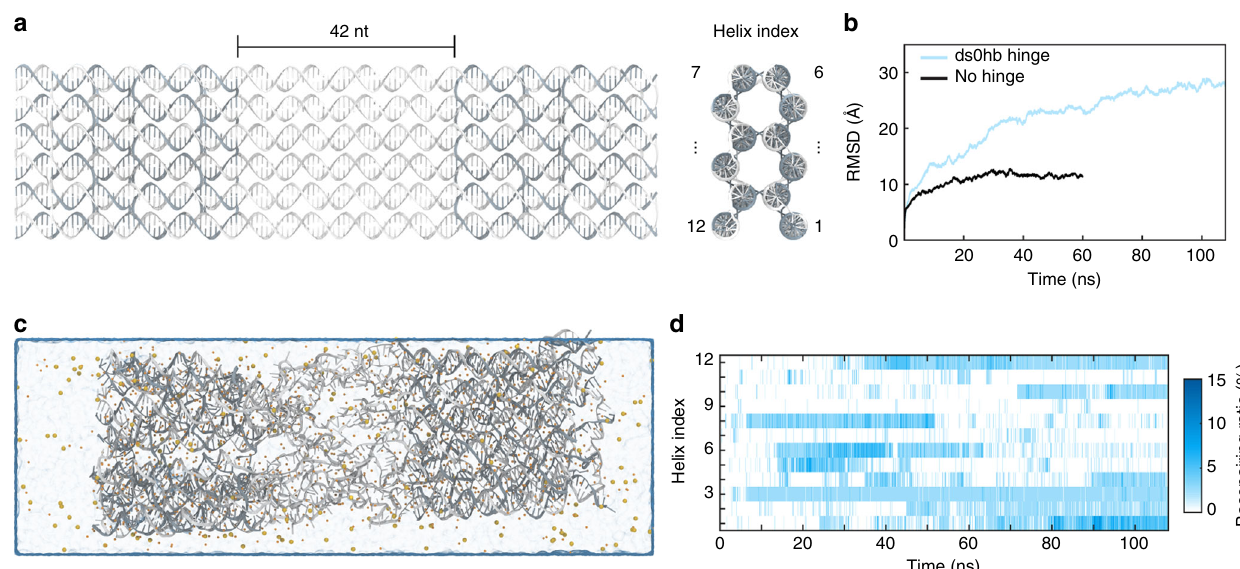
Fig. 4 MD simulation result of the hinge module. a Initial con fi guration of the structure. b Root-mean-square deviation (RMSD) value during MD simulation. c A snapshot showing the con fi guration of the hinged structure at the fi nal time step (after ~110 ns of simulation time). More snapshots of hinged and non-hinged structures were shown in Supplementary Figs. 25 and 26. d Base pairing ratio of each helix at the hinge module throughout the MD simulation. Base pairing can occur by the interaction of ssDNA bases between either same or neighboring helix